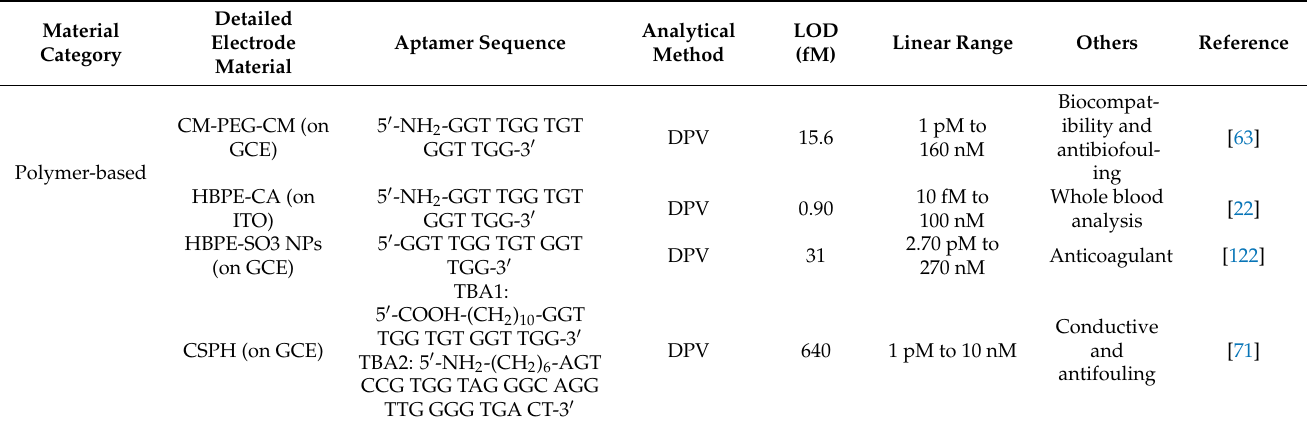
Table 4. Summary and comparison of polymer-based